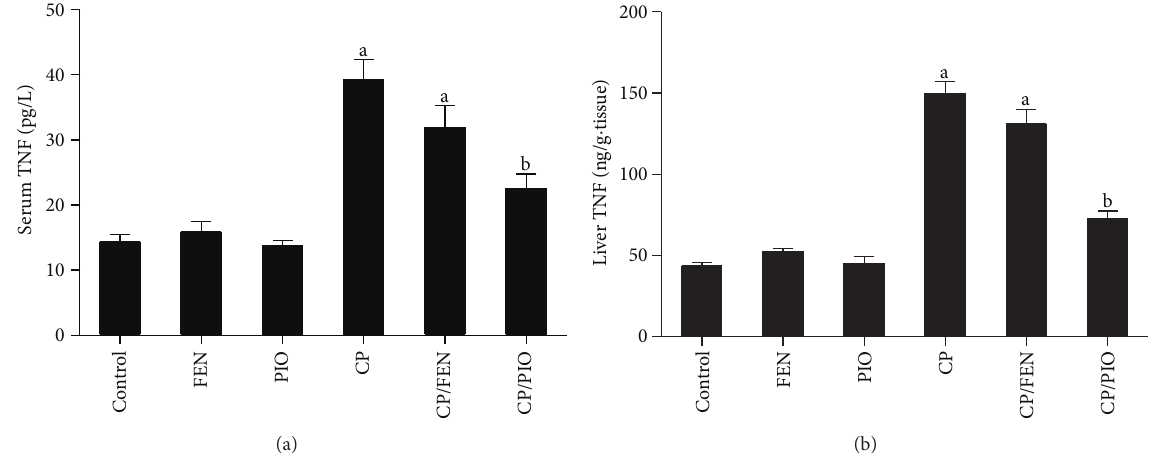
Figure 3: Effect of fenofibrate (FEN) and pioglitazone (PIO) on tumor necrosis factor (TNF)- 𝛼 levels in serum and liver of cyclophosphamide (CP)-treated rats. Values are representation of 8 observations as means ± SEM. Results are considered significantly different when 𝑃 < 0.05. a Significant difference compared to control, b significant difference compared to CP